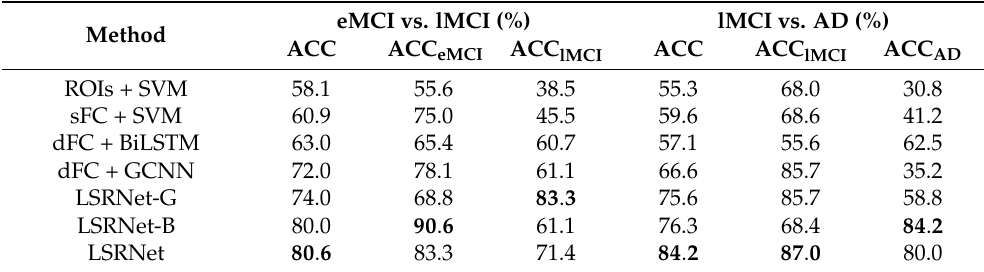
Table 2. Performance of the proposed method on partial metrics (eMCI vs. lMCI, lMCI vs. AD) on binary